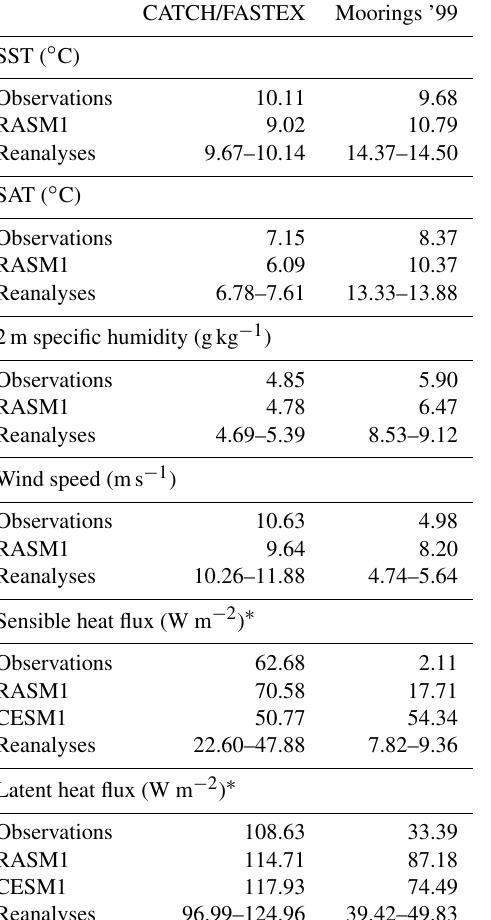
Table 1. Comparison of cruise mean observations and simulated values of surface meteorology and turbulent